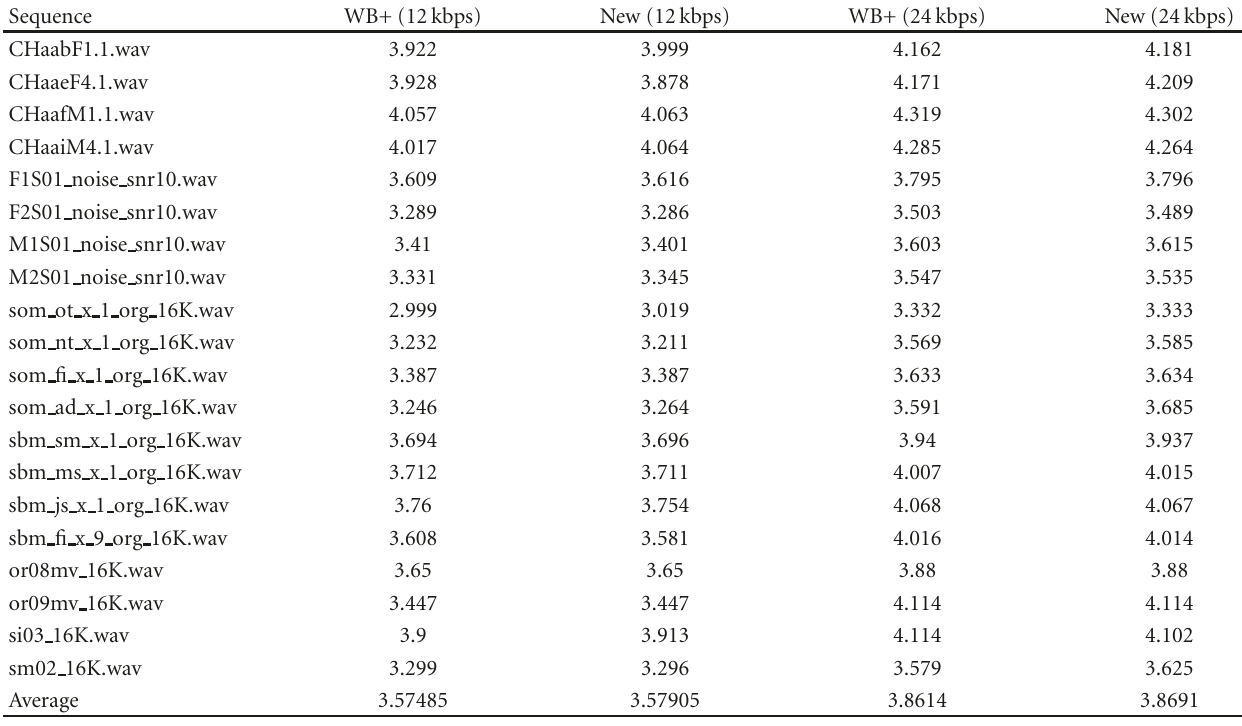
Table 4: PESQ comparison at 12/24kbps.